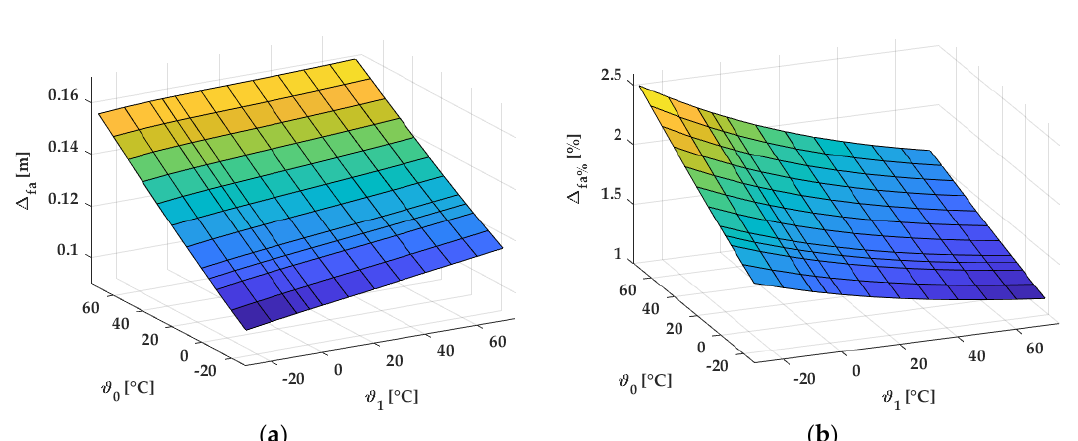
Table 8. Maximum absolute sag deviations Δ fa [m] caused by the incorrect determination of the tower span by −2 .5 m.